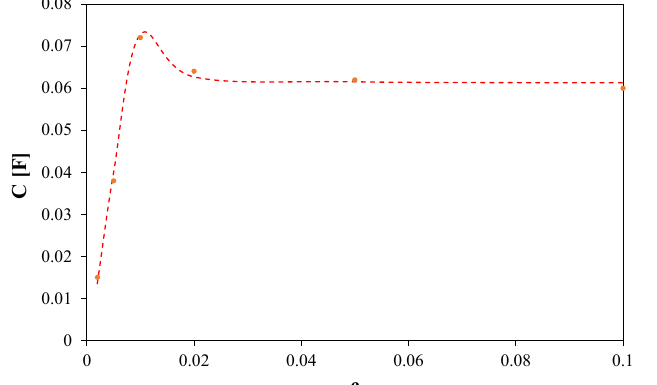
Figure 9. Calculated and measured dependencies of the electrolyzer electric capacity on the electrolyte concentration.